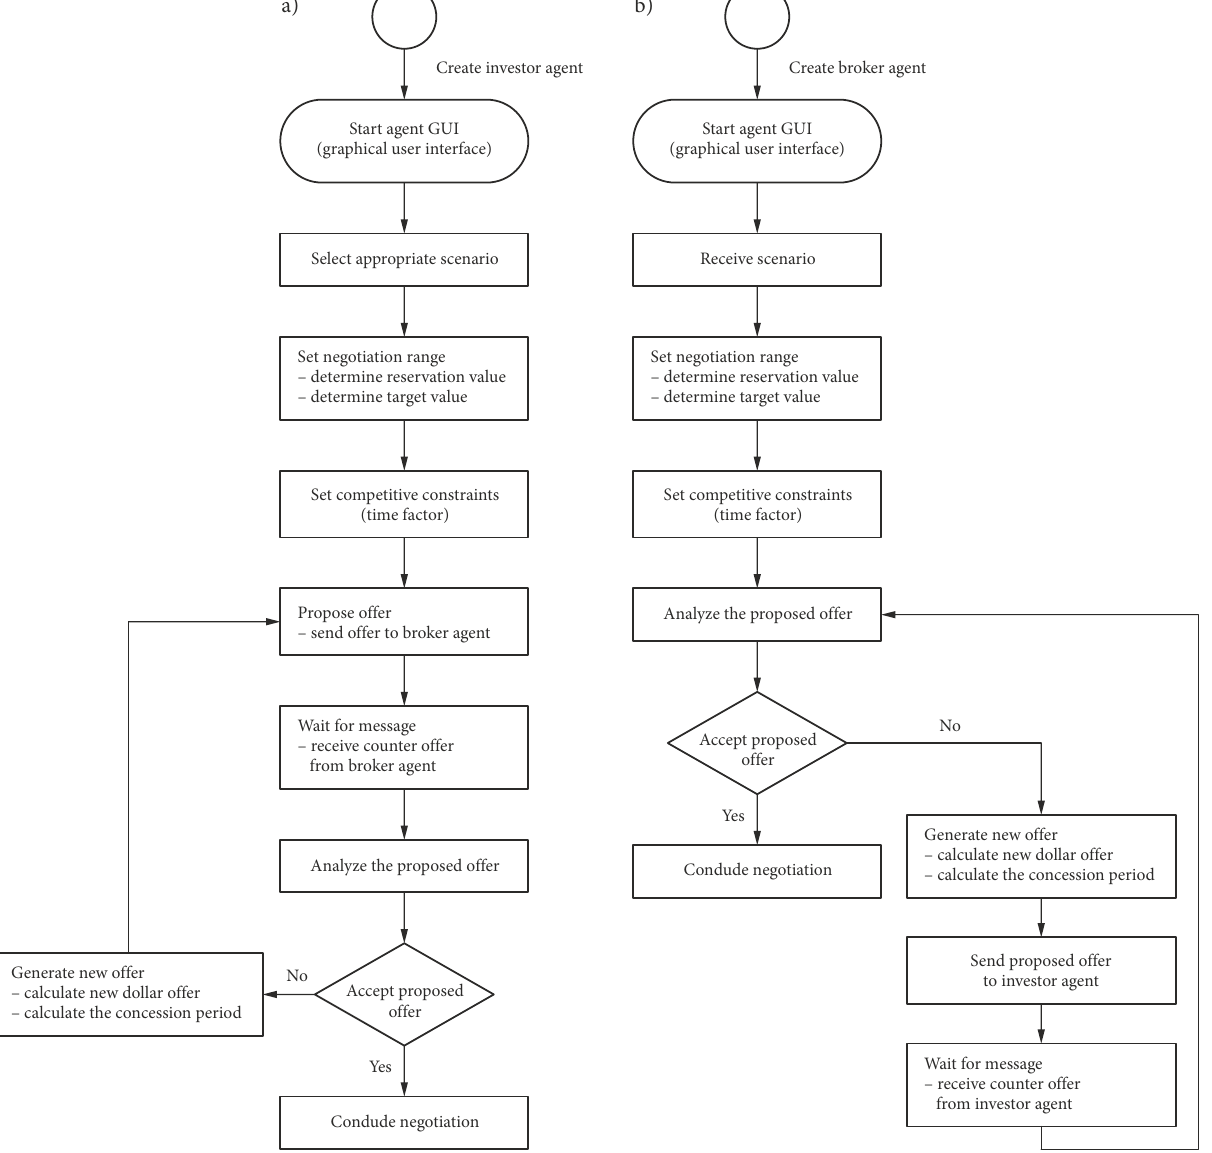
Figure 3. (a) State diagram for investor’s behavior; (b) State diagram for broker’s